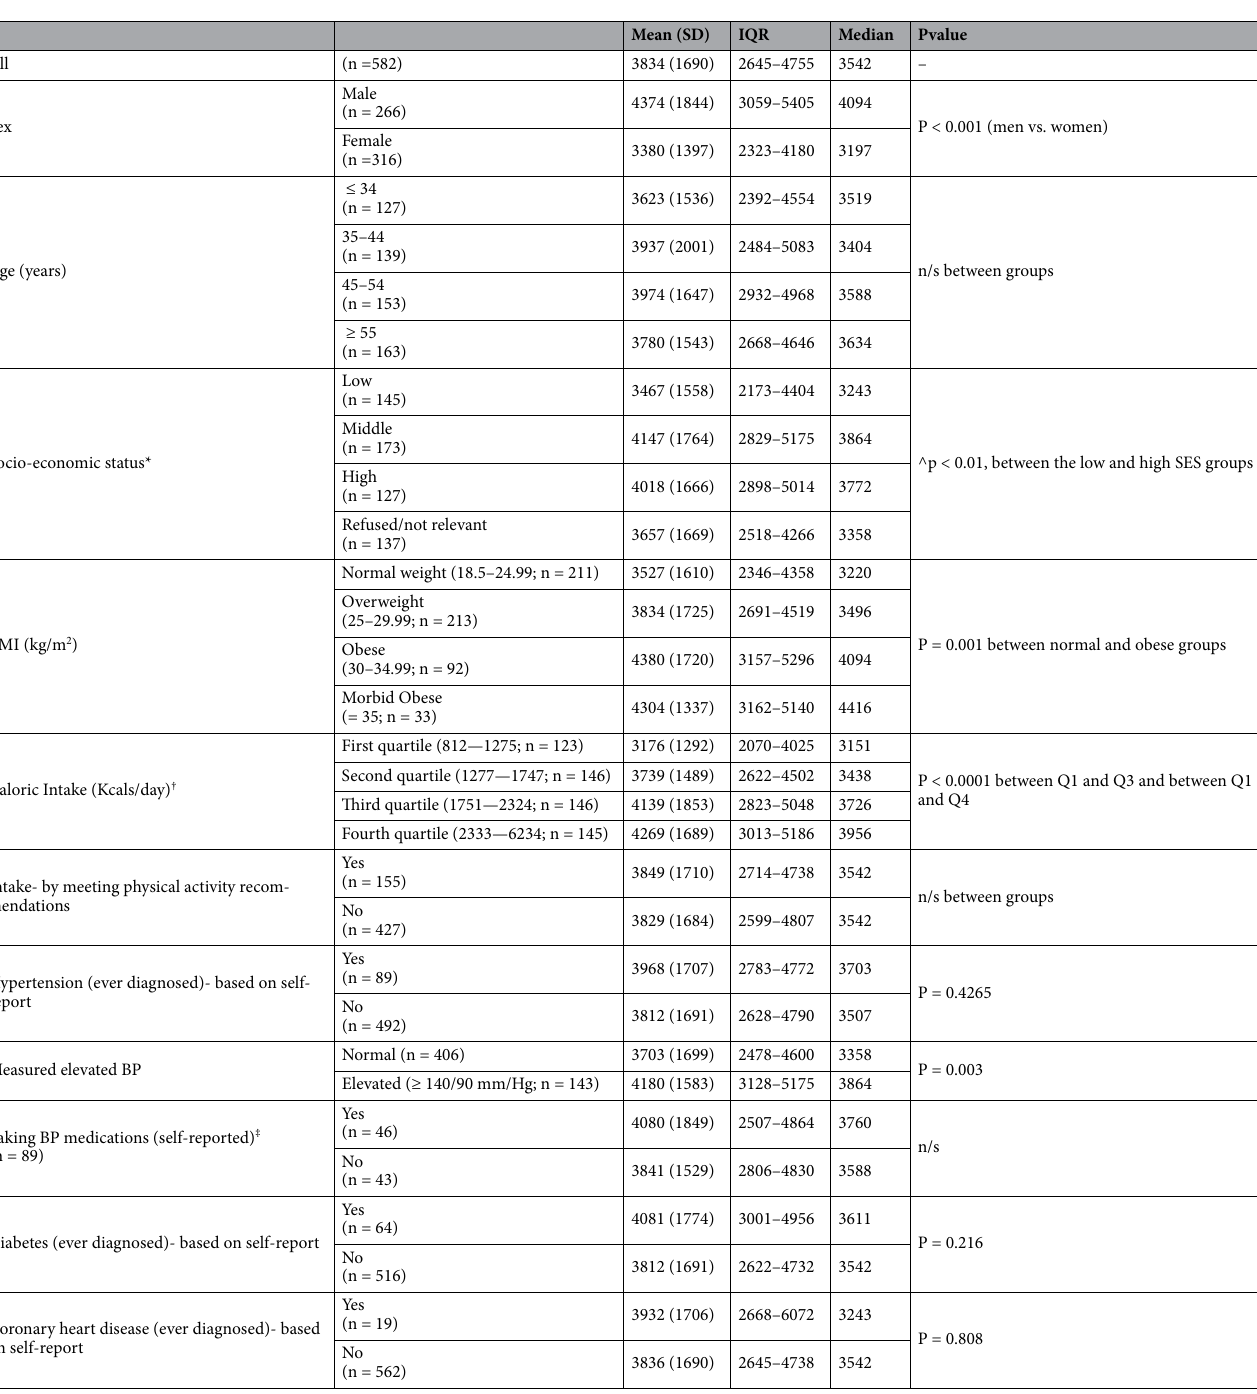
Table 2. Sodium excretion (mg) by demographic and health characteristics—as measured in the 24-h urine collection. BMI Body Mass Index, BP Blood Pressure, IQR Inter Quartile Range, SD Standard Deviation. *As indicated in Table 1. † Excluding individuals with caloric intake < 800 kcals. ‡ Of those reporting having